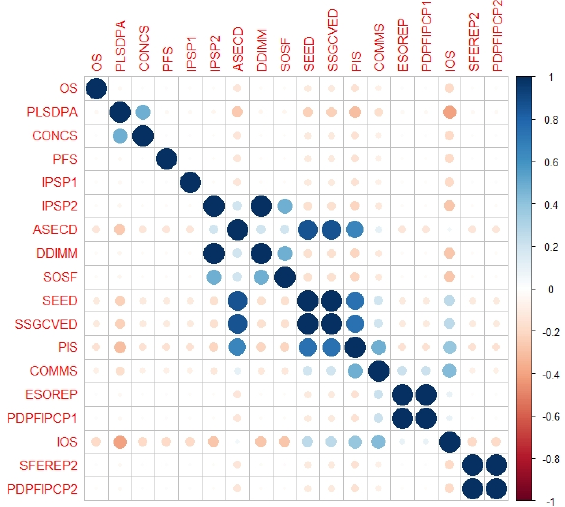
Figure 5. Correlation matrix reflecting dependencies between different phases and stages of the Fort Bema (Parkowo-Le ś ne Housing Estate) project. A correlation heatmap is yet another graphical representation of the correlation matrix (see Figure 6).